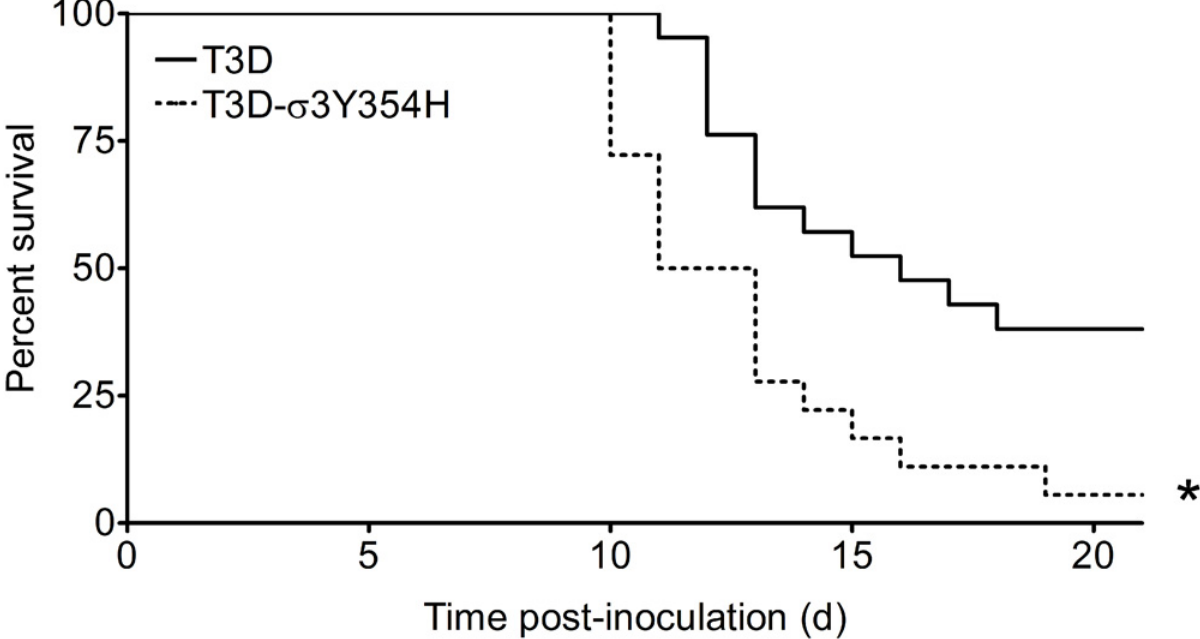
Fig 1. The σ 3-Y354H mutation enhances reovirus virulence following intramuscular inoculation. Newborn C57BL/6J mice were inoculated in the left hindlimb with 10 5 PFU of T3D or T3D- σ 3Y354H. Mice (n = 18 and 21 for T3D and T3D- σ 3Y354H, respectively) were monitored for survival for 21 days. * , P < 0.001 as determined by log-rank test in comparison to